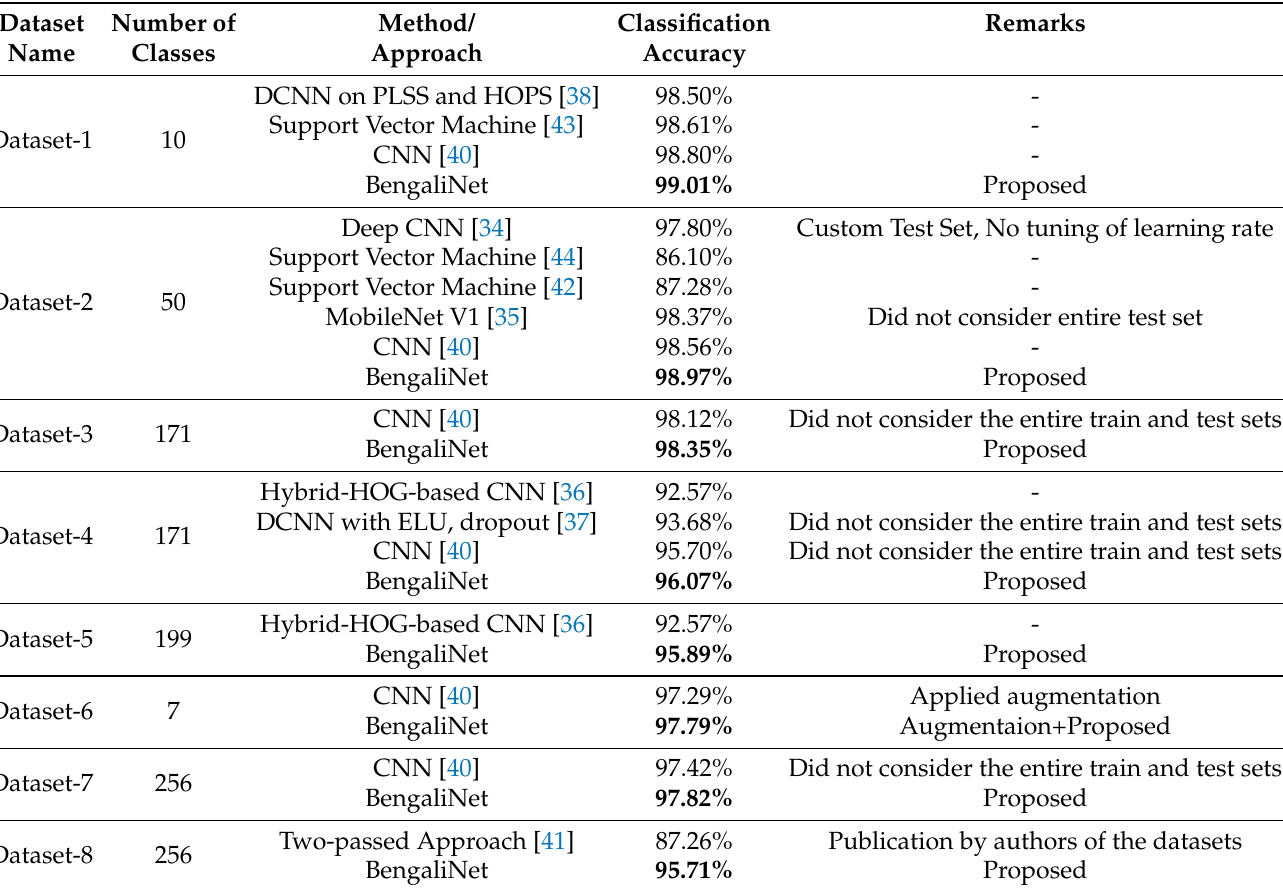
Table 7. Comparison among results obtained by our proposed BengaliNet and previous